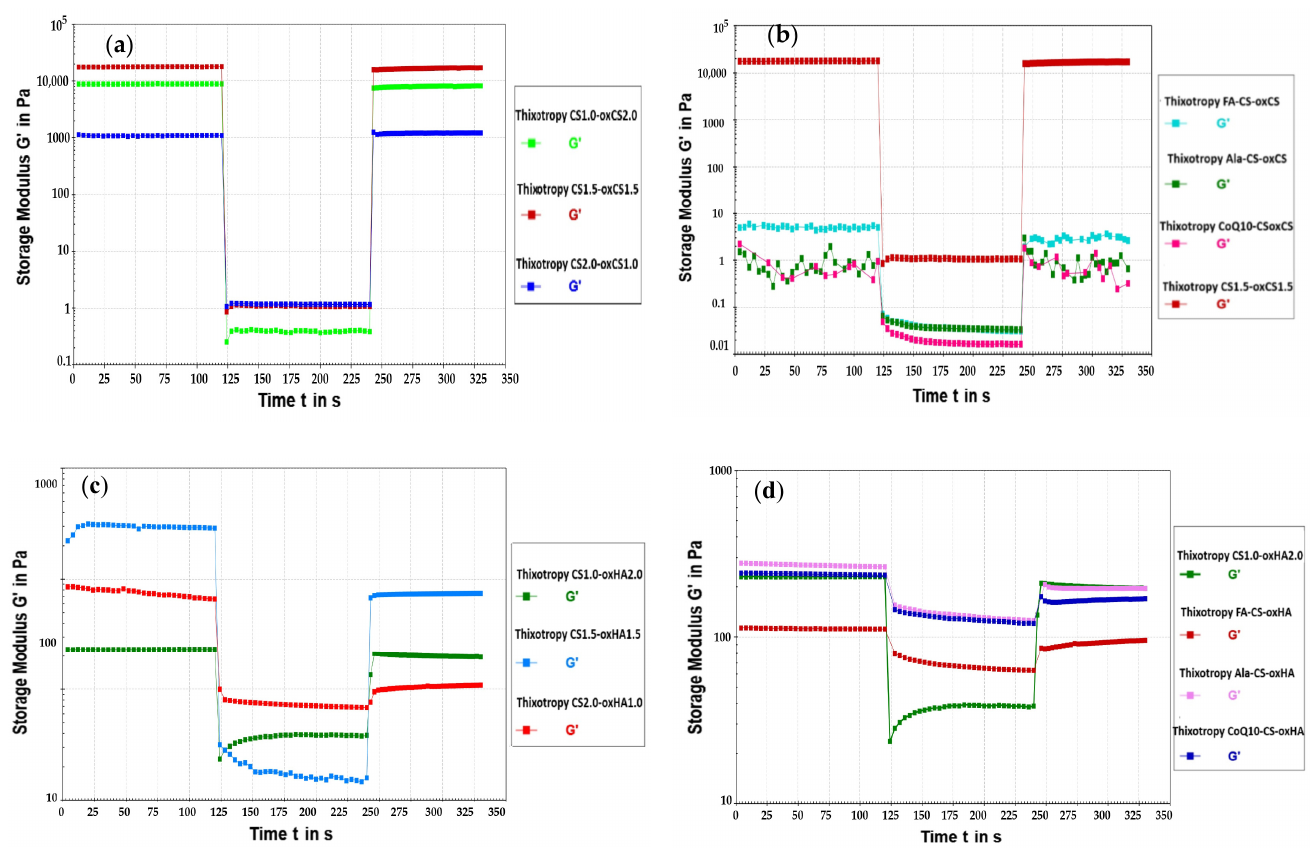
Figure 10. The thixotropic behavior digram of CS-oxCS ( a ), API-CS-oxCS ( b ), CS-oxHA ( c ), and API-CS-oxHA ( d ) hydrogels. Table 7. The thixotropic test parameter value recorded for CS-oxCS/oxHA and API-CS- oxCS/oxHA